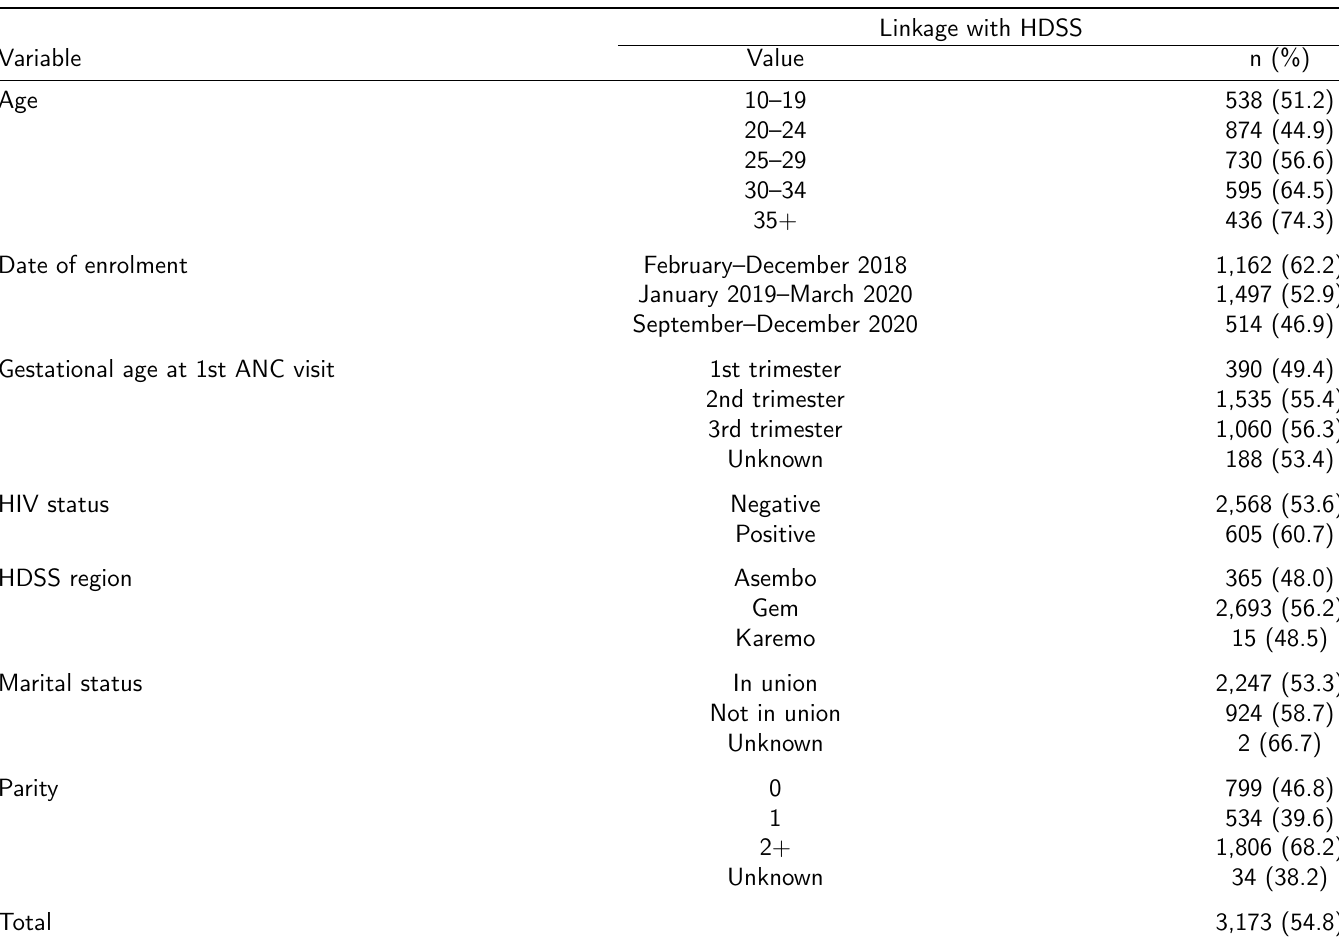
Supplementary Table 1: Characteristics of individuals visiting antenatal care (ANC) clinics that were linked to Siaya Health and Demographic Surveillance System